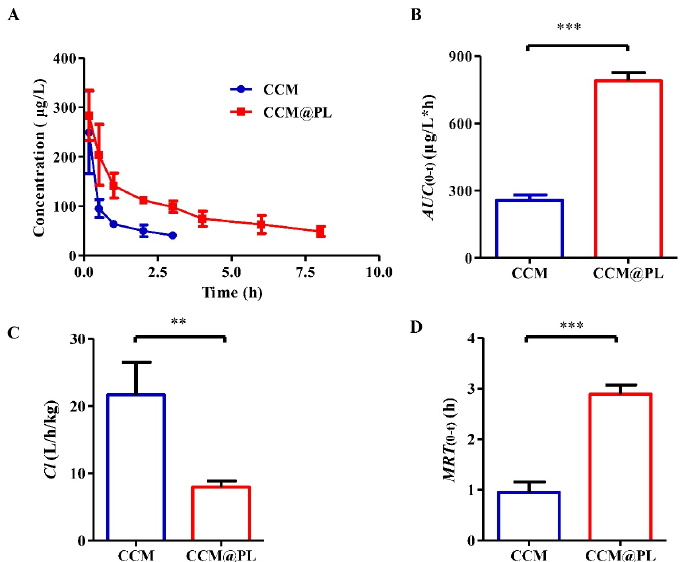
Figure 2. The in vivo kinetic characteristics of CCM or CCM@PL in Sprague Dawley rats following intravenous administration. ( A ) Plasma concentration of CCM or CCM@PL. ( B ) The area under the concentration-time curve ( AUC ), ( C ) clearance ( Cl ), ( D ) mean residence time ( MRT ) of CCM or CCM@PL. Data are presented as the means ± SDs ( n = 4). ** p < 0.01, and *** p < 0.001.